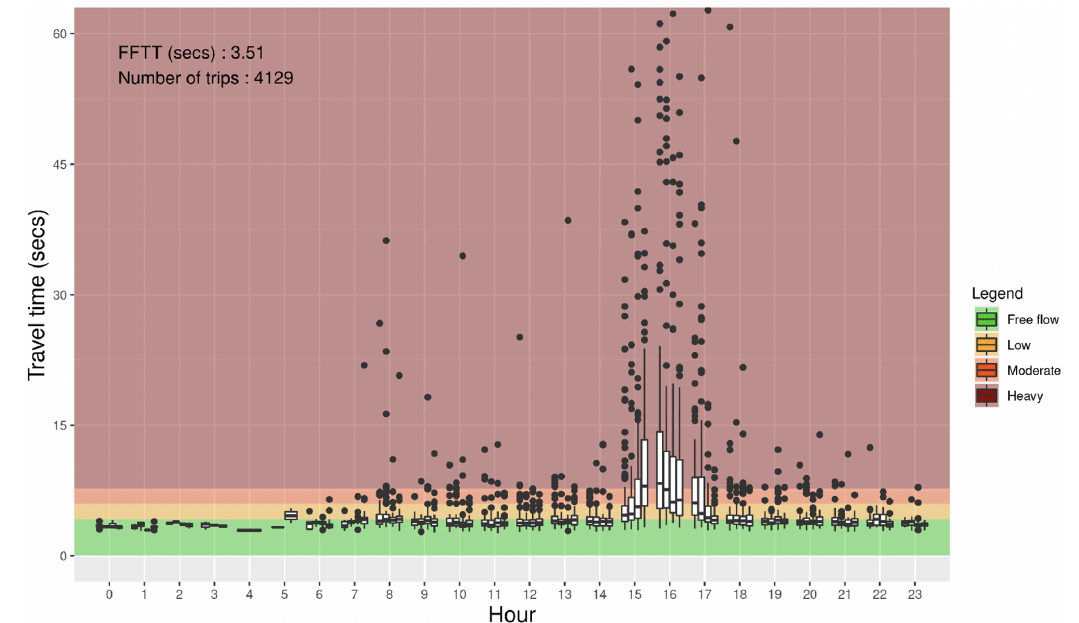
Figure 7. Travel time boxplots as a function of time of the day with TTI classes observed on osm_id